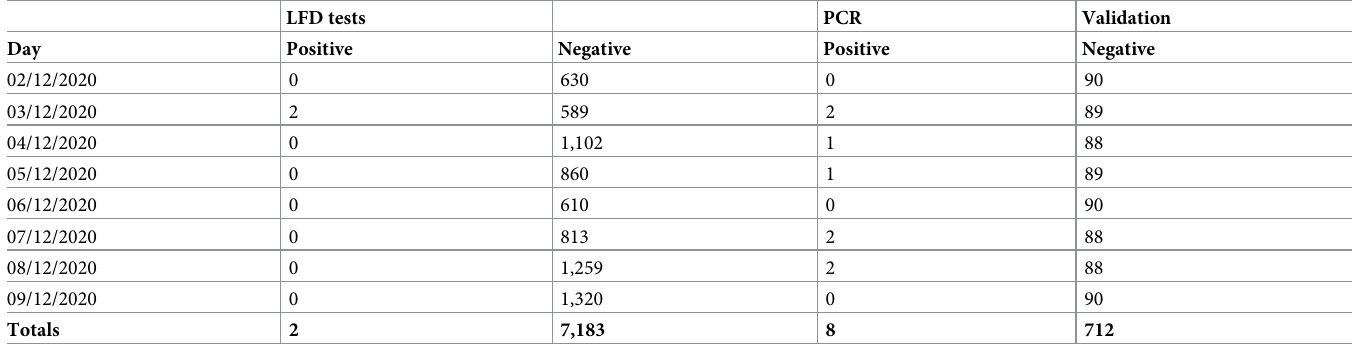
Table 1. Table of results for Lateral Flow Device testing of University of Birmingham students and confirmatory PCR testing of approximately 10% of samples.